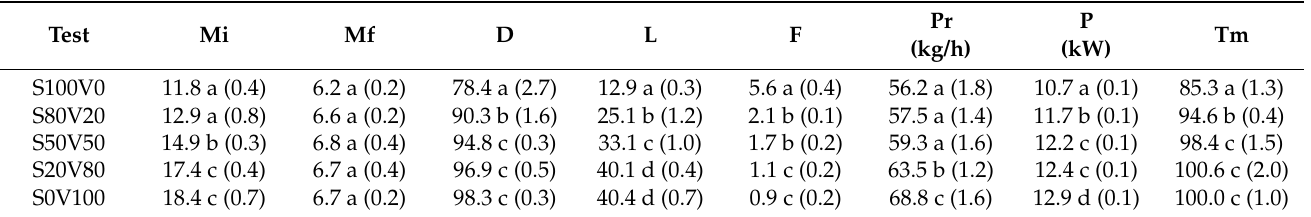
Table 7. Results of pelletisation tests with different blends of vineyard pruning residues and spruce sawdust (average values with standard deviation in